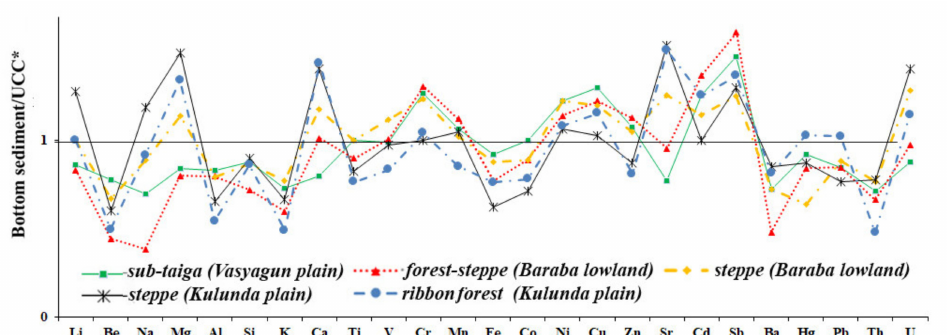
Figure 3. The multi-element spectrum of the average values of the studied elements for bottom sediments of lake systems in the different type of landscape of South of Western Siberia (according to our data) normalized to the values of the upper continental crust (UCC) contents according to [39]. A comparison of the data on the average values of the studied elements in the bottom sediments of Siberian lakes and their catchment area soils shows that higher contents of Sb, as well as Ca, Mg, Sr (the steppe landscape), and Cd (Baraba forest-steppe landscapes) were recorded in the bottom sediments of all landscape zones (Figure 4). The contents of the other elements are at the same level as the content of these metals in the soils of the catchment areas.